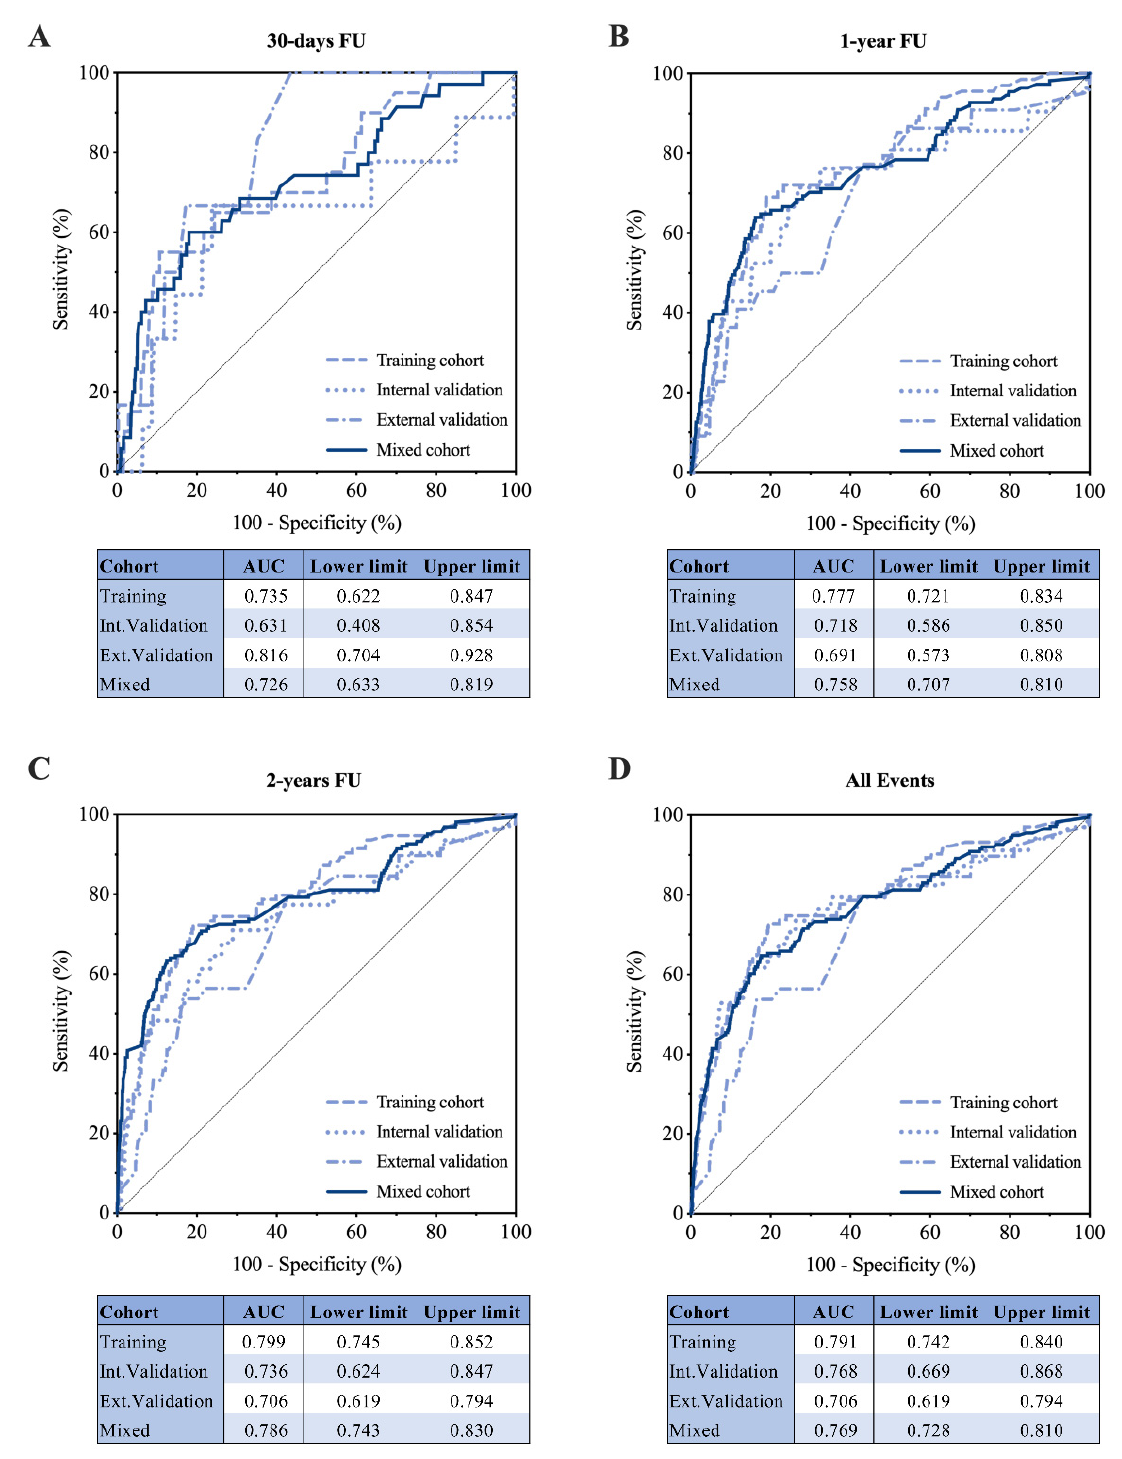
Figure 2. Predictive performance. Receiver operating characteristics curve to assess the area under the curve and its 95% confidence interval (lower and upper limits) for the RAIN-ML prediction model at training (n = 1795), internal (n = 598), external validation (n = 1701), and in the mixed cohort (n = 4094). ( A ) Performance at 30-day follow-up; ( B ) Performance at 1-year follow-up; ( C ) Perfor- mance at 2-year follow-up; ( D ) Performance considering all the events at follow-up.